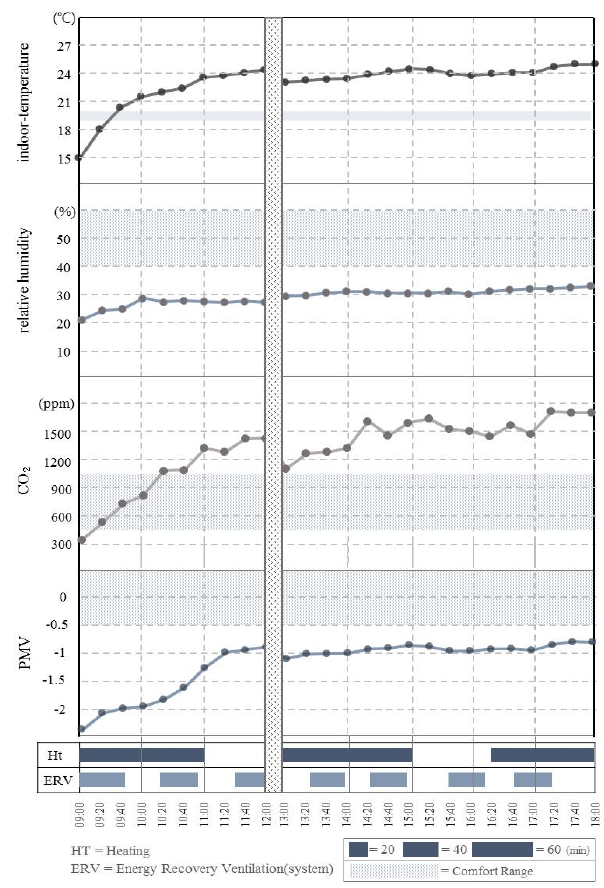
Figure 3. Results graph of the control Figure 2. Results graph of the control group.